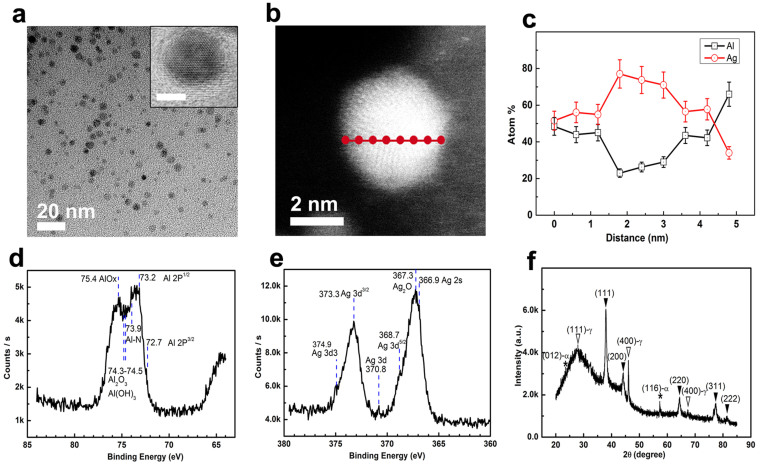
Wide-viewed TEM image (a), HR-TEM image of one single particle (a: inset, scale bar: 2 nm), STEM-HAADF image of one single particle (b), point-by-point EDX scanning of one single particle (c), high energy resolution XPS for Al (d), high energy resolution XPS for Ag (e) and XRD (f) for AgAl@Al(1-x)AgxOy nanohybrids synthesized using aqueous-phased metal salt reaction systems.JCPDS No for XRD analysis: fcc Ag, 15-0806; fcc Al, 04–0787; α-Al2O3, 46-1212; γ-Al2O3, 10-0425;. In XRD (f), : the corresponding metallic phases;  and *: the corresponding metal oxides.